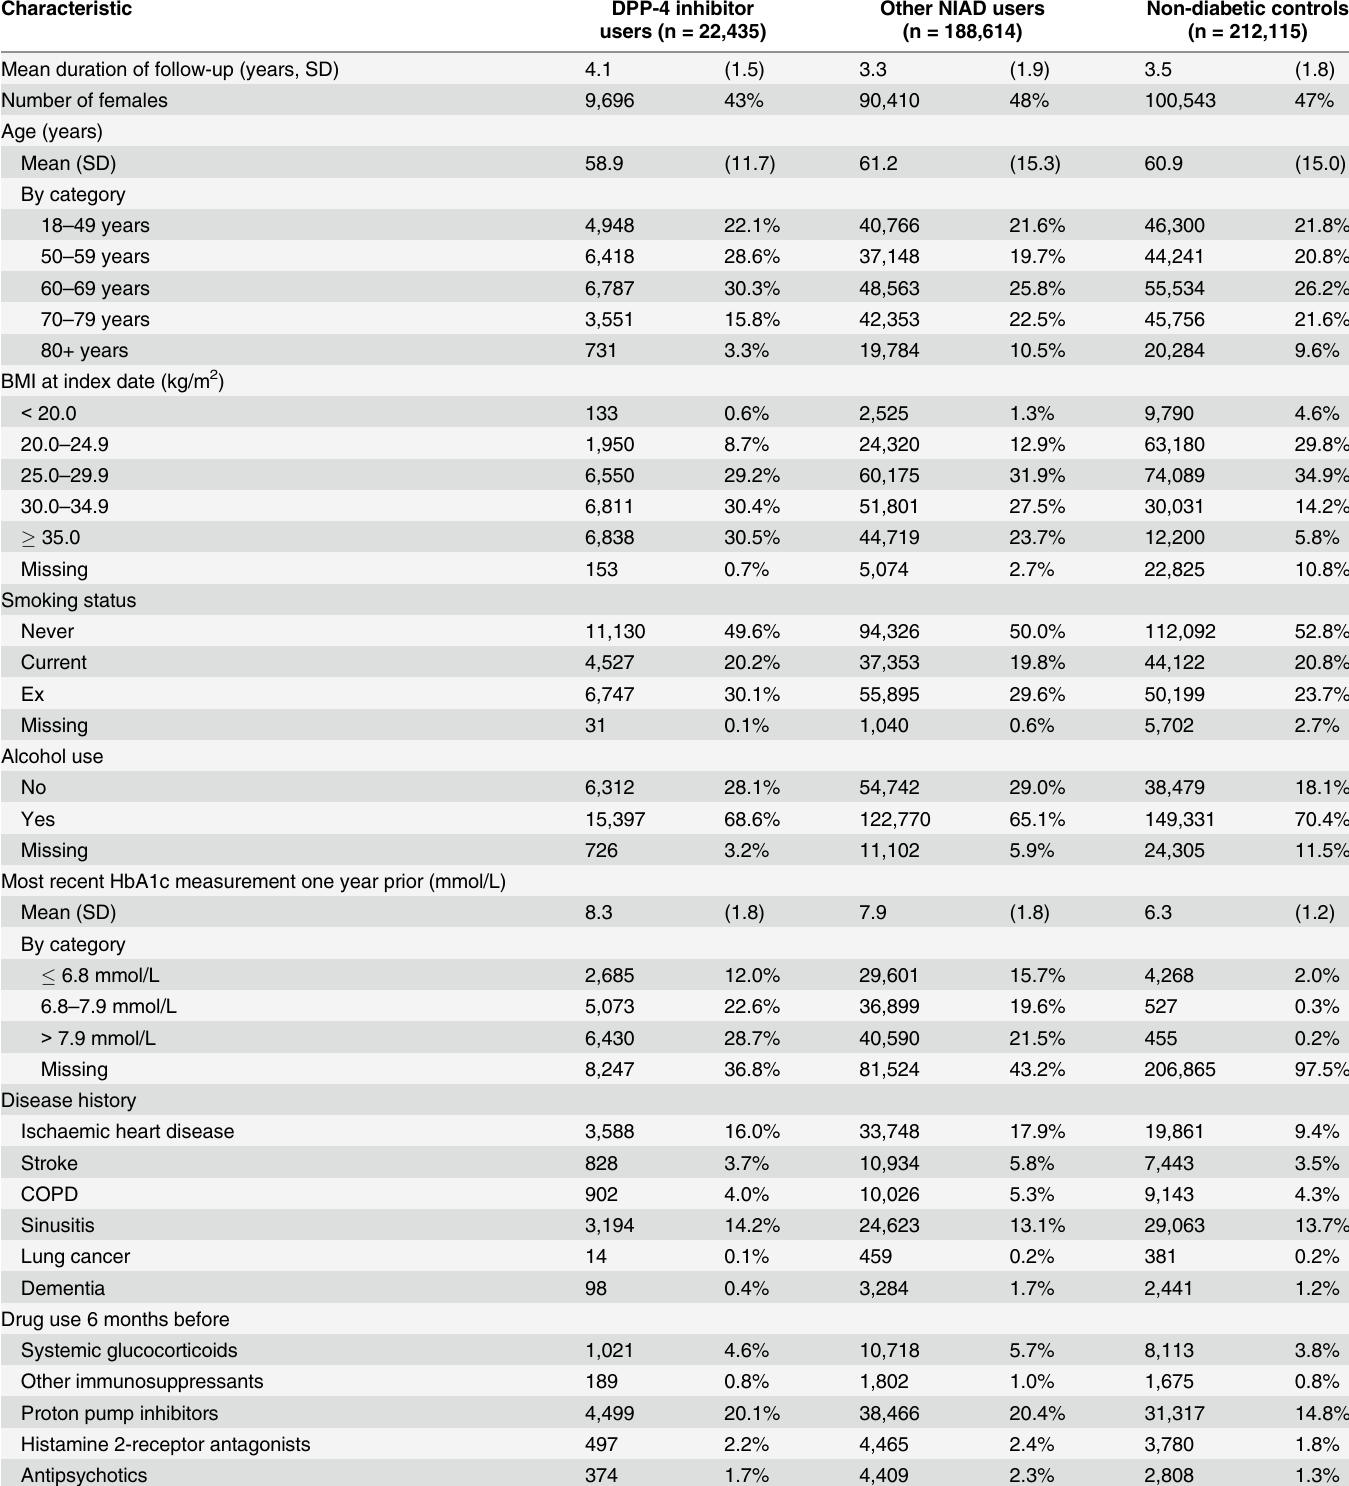
Table 1. Baseline